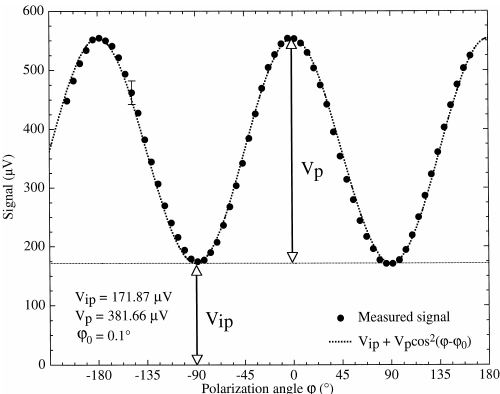
Figure 12. Polarization-dependent and independent response of the tunneling diode with the values of both components shown in the figure. Diodes are connected to the integrated dipole and bow tie antennas as described in [28]. The linear polarization angle φ of the incident radiation is changed, and the DC response of the diode is monitored. A 10.6µm laser was used with other facilities to obtain 5 × 10 6 Wm − 2 intensity at the antenna under test (Reproduced with permission from [28], Elsevier,